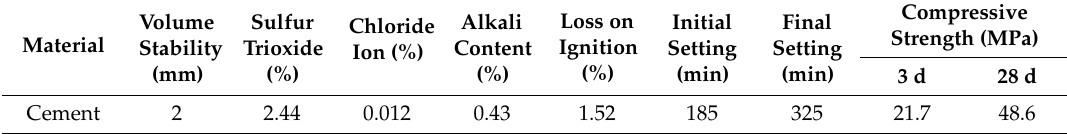
Table 1. Performance index summary of silicate with low alkaline cement.